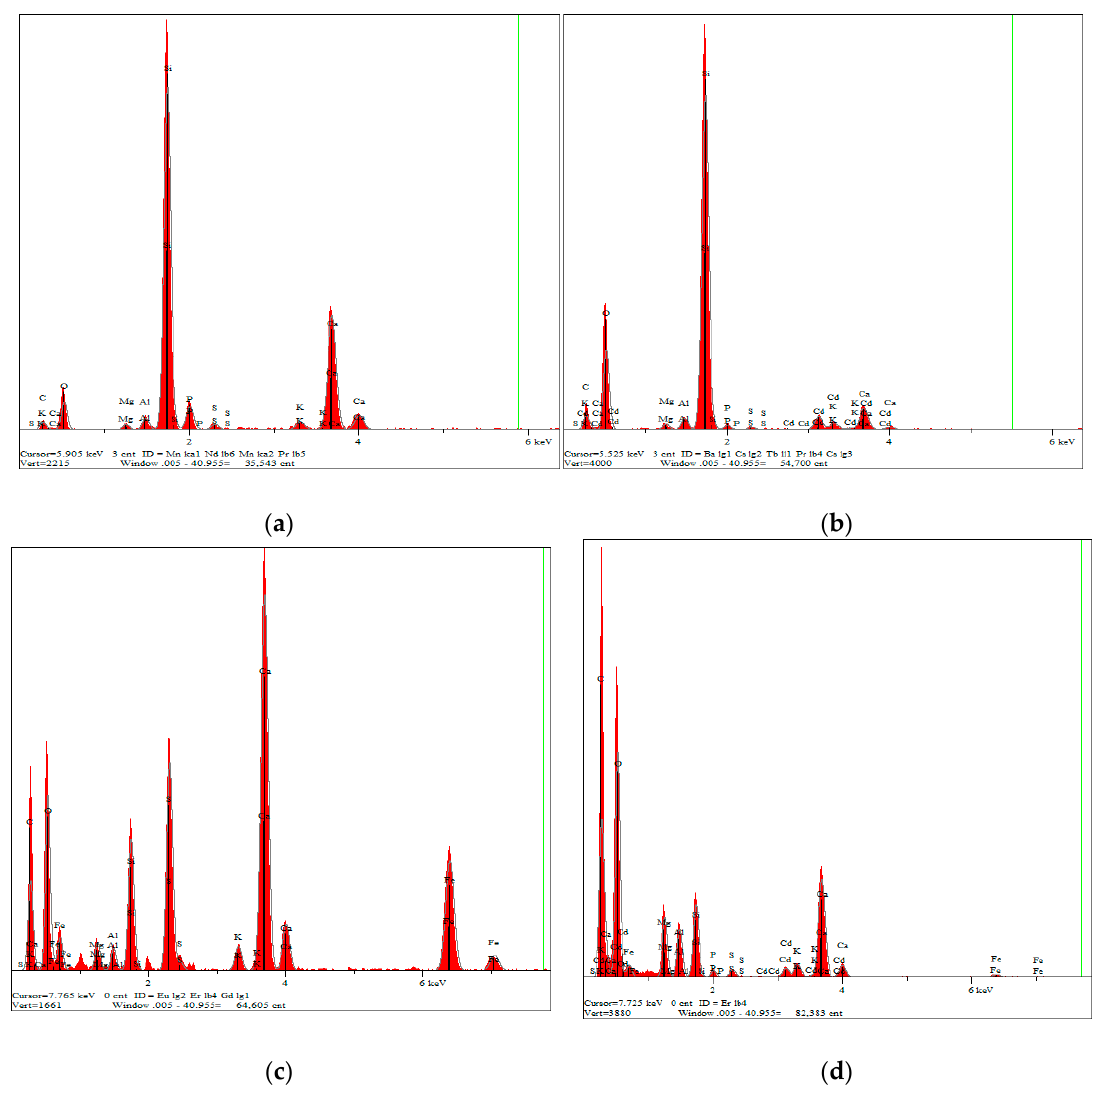
Figure 12. Energy dispersive X-ray (EDS) analysis ( a ) MSB500, ( b ) Cd-loaded MSB500, ( c ) PLB500, and ( d ) Cd-loaded PLB500.